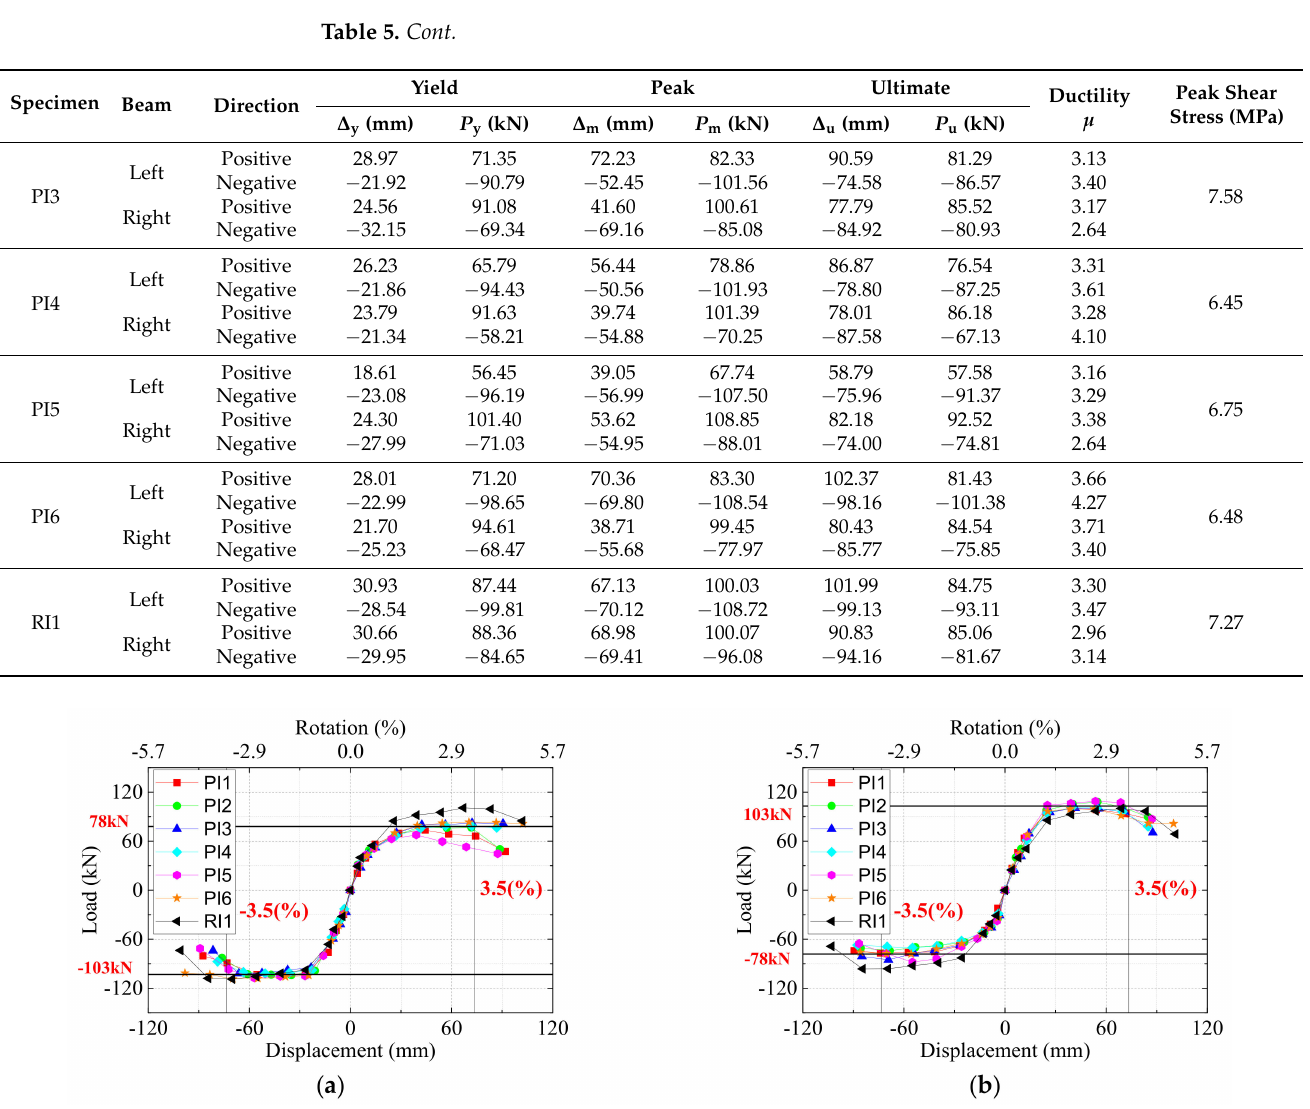
Figure 7. Load–displacement envelope curves. ( a ) Left beams, ( b ) right beams. For the typical specimen PI4, the hysteretic curves were almost linear before the predicted yield displacement. The load reached the maximum value of +78.86 kN and − 101.93 kN for the left beam at the displacement of +56.44 mm (drift ratio = +2.69%) and − 50.56 mm ( − 2.41%). The maximum load of the right beam reached +101.39 kN and − 70.25 kN at the at the displacement of +39.74 mm (+1.89%) and − 54.88 mm ( − 2.61%). As the displacement increased to +86.87 mm (+4.14%) in the positive direction for the left beam and − 87.58 mm ( − 4.17%) in the negative position for the right beam, the load maintained about 0.96 times that of the peak load. The strength degradation was quite slight although the displacement was very large. This was caused by the existence of strands at the bottom of the beam. The bond slip was not evident based on observation of the plump hysteretic load–displacement curves of beams. The curves also proved that the strands were able to yield and the anchorage length of strands was adequate. For the specimen PI1, the axial ratio was raised up from 0.03 to 0.1, the hysteretic curves showed comparable features to those of PI4, as shown in Figure 6a,b. The result indicated that a relatively lower axial ratio had little impact on seismic performance for the joints that suffered from beam flexural failure. However, as the displacement increased to − 75 mm for the left beam, the curves became pinching due to the severe concrete spalling of left beam end which can be seen in Figure